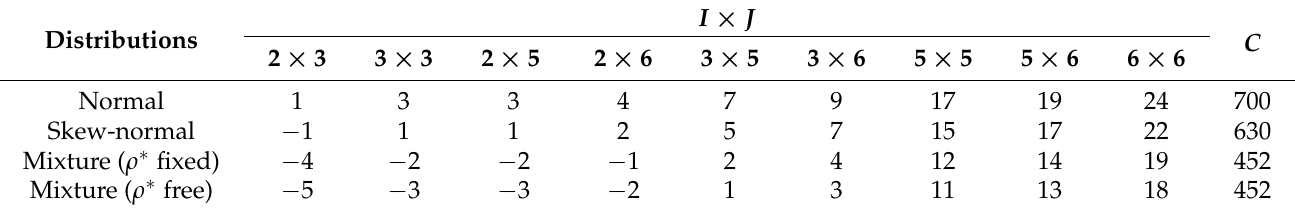
Table 2. The degrees of freedom to test underlying bivariate distributions among different contingency